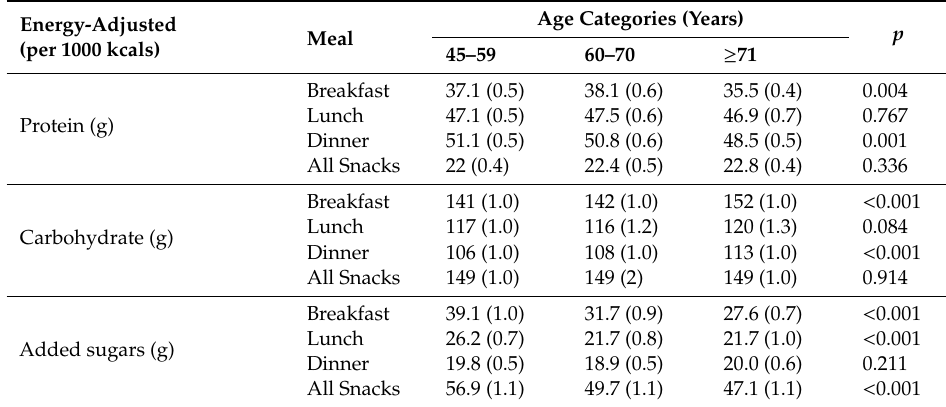
Table 4. Mean macronutrient density of intakes by meals and